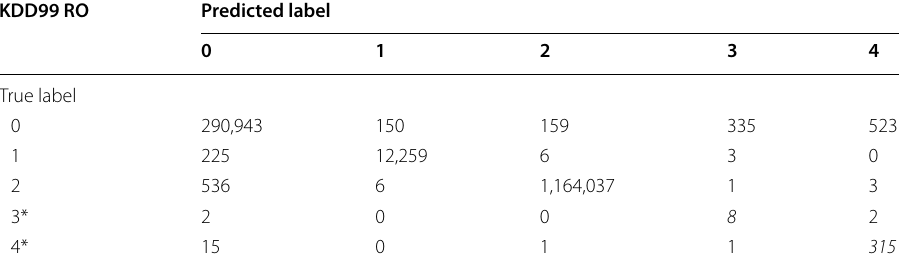
Table 15 Confusion Matrix: KDD99 RO KDD99 RO